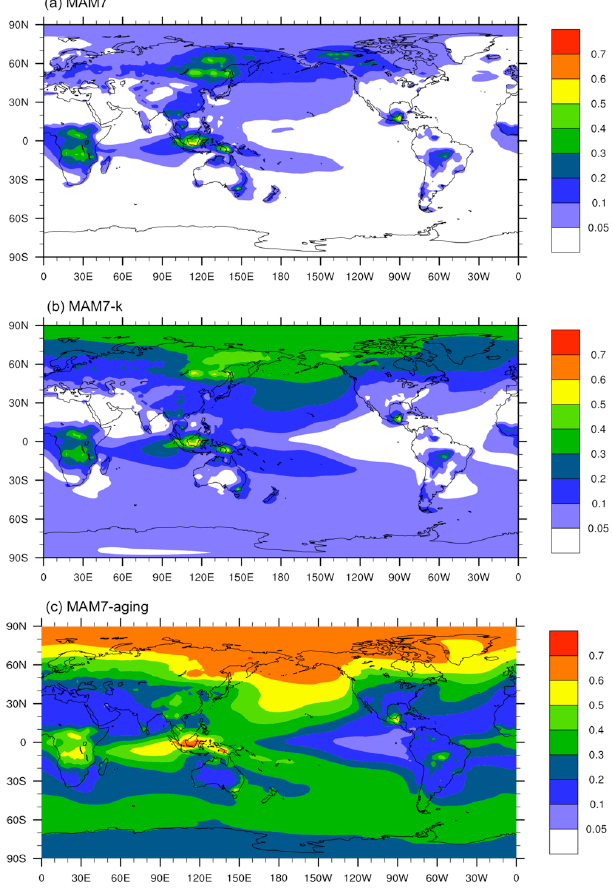
Fig. 26. Mass fraction of the total BC column burden that is in the primary carbon mode from the three experiments: MAM7, MAM7- k and